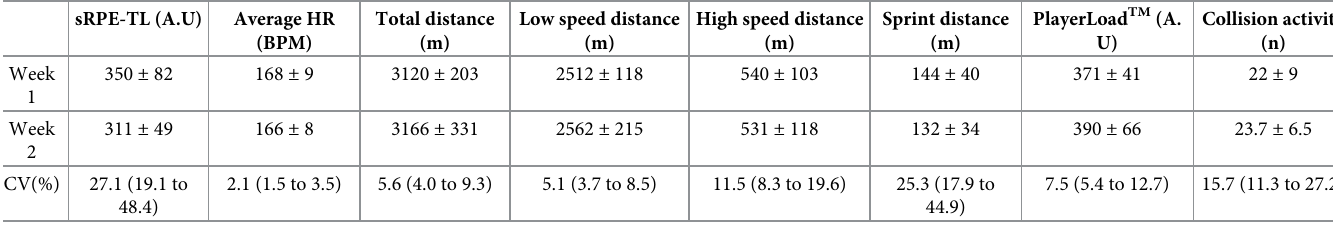
The training load data are presented as mean ± SD. The changes between Week 1 and 2 are presented as typical error expressed as coefficient of variation (CV%) and 90% confidence intervals. sRPE-TL stands for session rating of perceived exertion–training load. A.U stands for arbitrary units. HR stands for heart rate. BPM stands for beats per